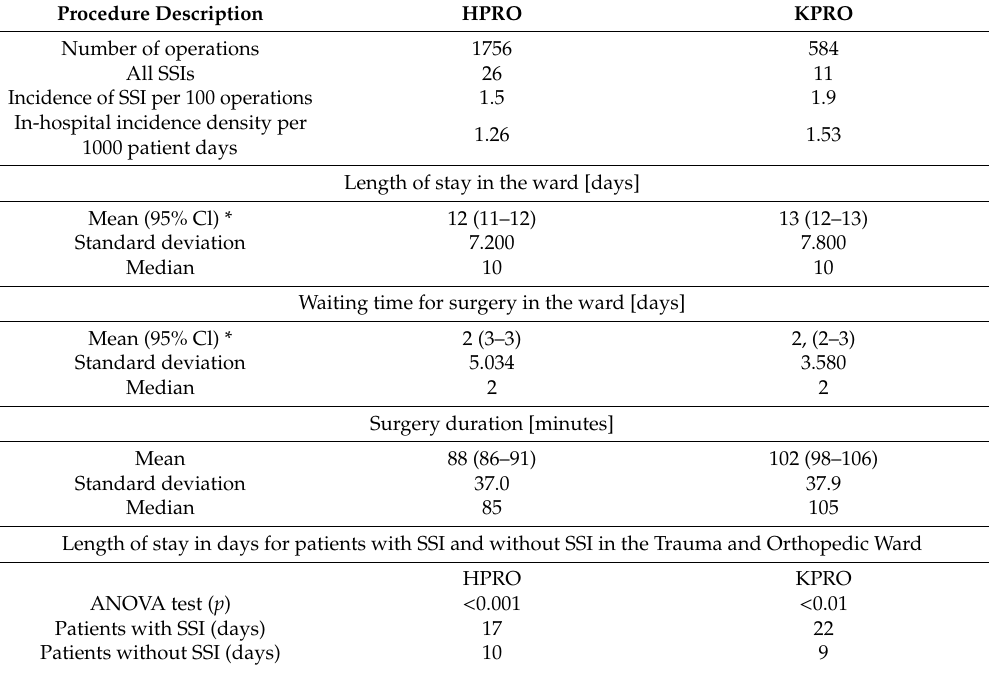
Table 3. Number of days of patients’ stay in the ward, waiting time for surgery, operation duration, number of days of patients’ stay in the ward by type of surgery and patients with or without SSI.